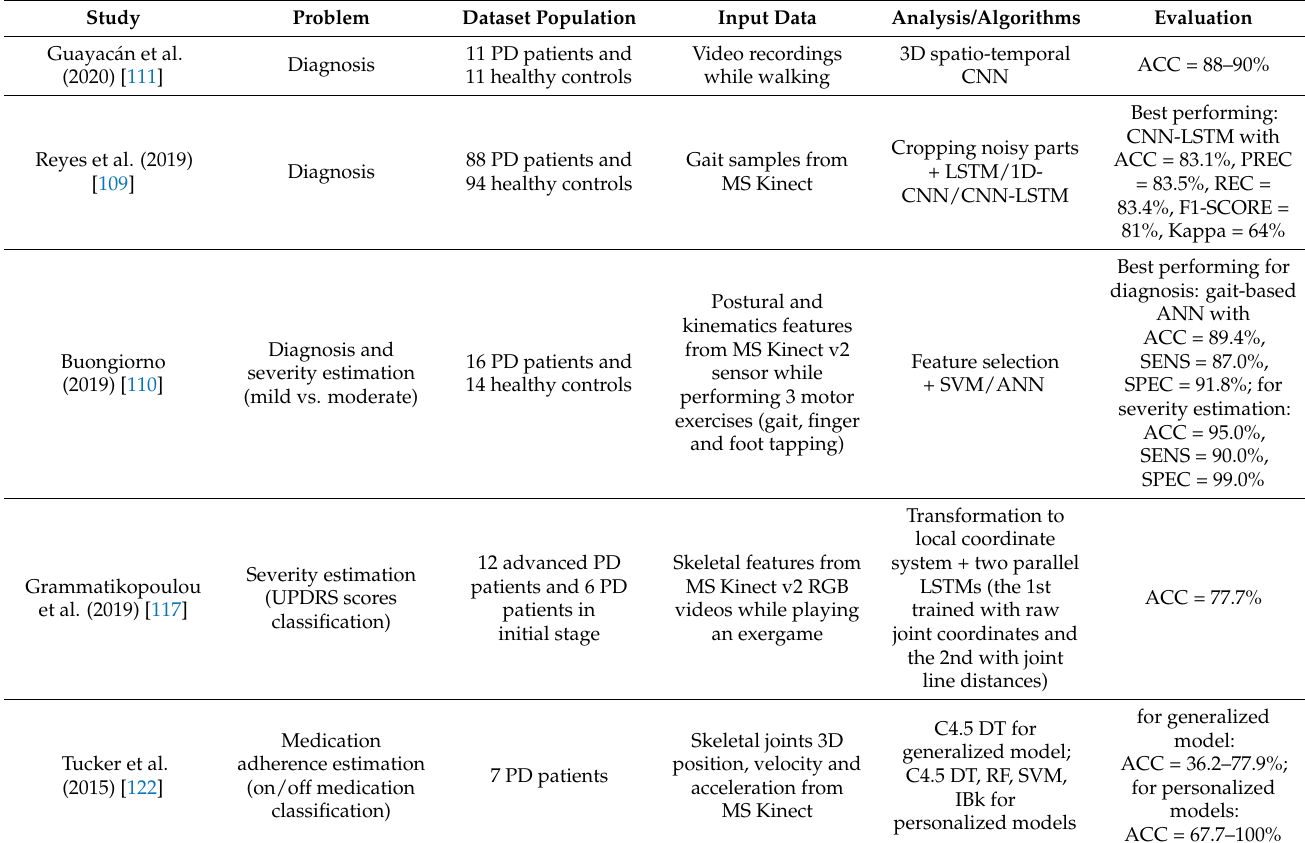
Table A3. Studies based on image and depth